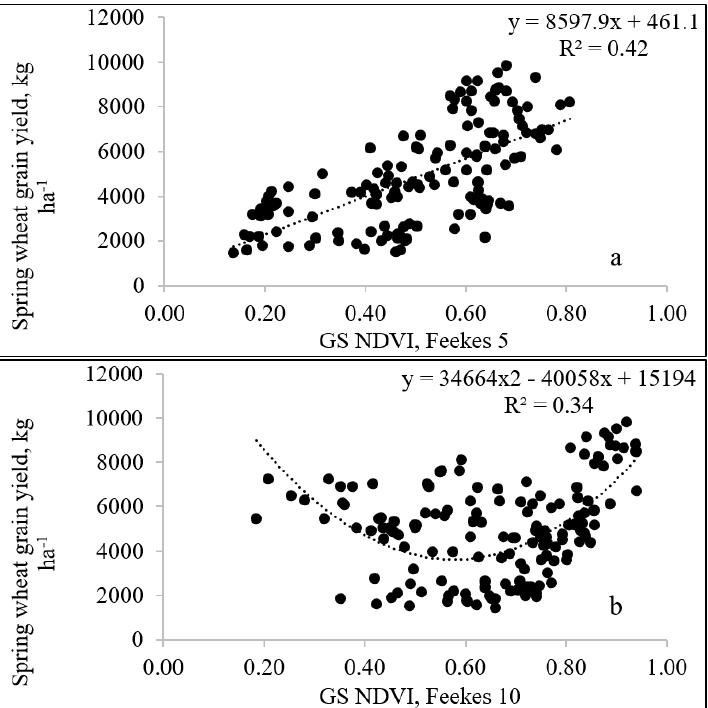
Figure 3. Relationship between Normalized Difference Vegetative Index (NDVI) at Feekes 5 ( a ) and Feekes 10 ( b ) growth stages collected using the GreenSeeker (GS) sensor and spring wheat grain yield (kg ha −1 ) for fourteen site-years in Idaho, 2015 – 2017.